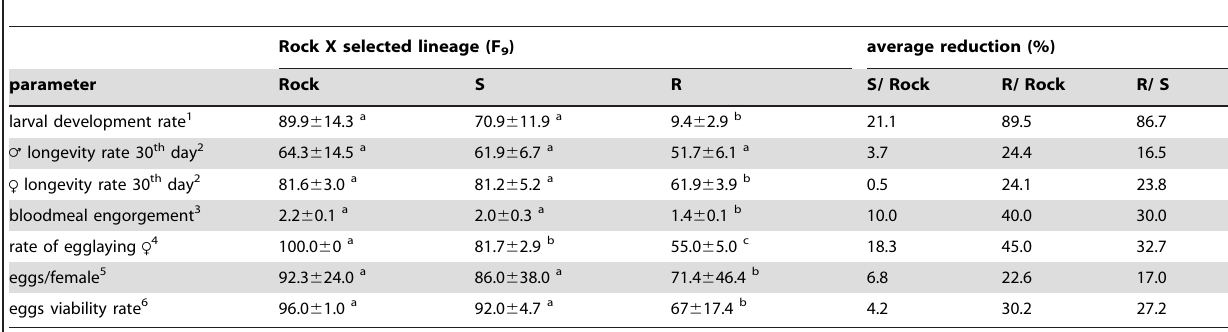
Table 3. Life-trait parameters of S and R lineages at F9 generation in comparison with the Rockefeller